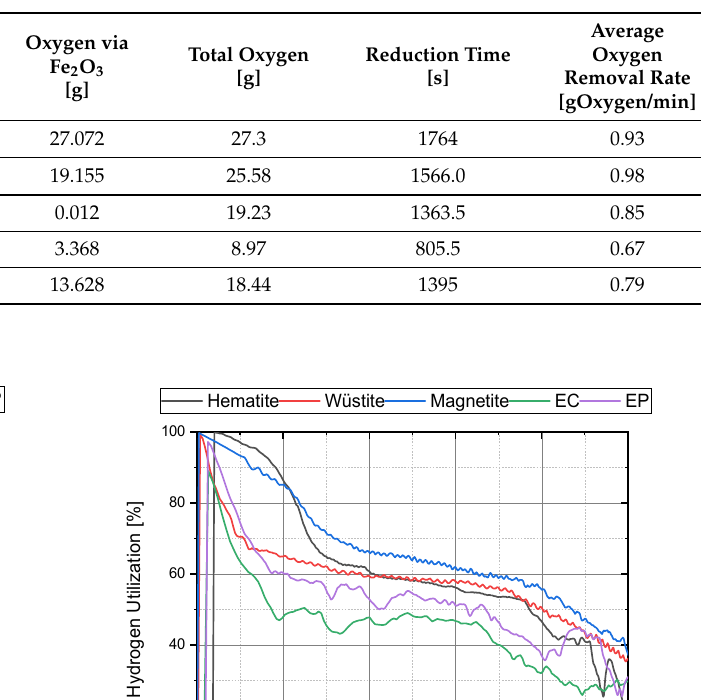
Table 4. Oxygen budget.